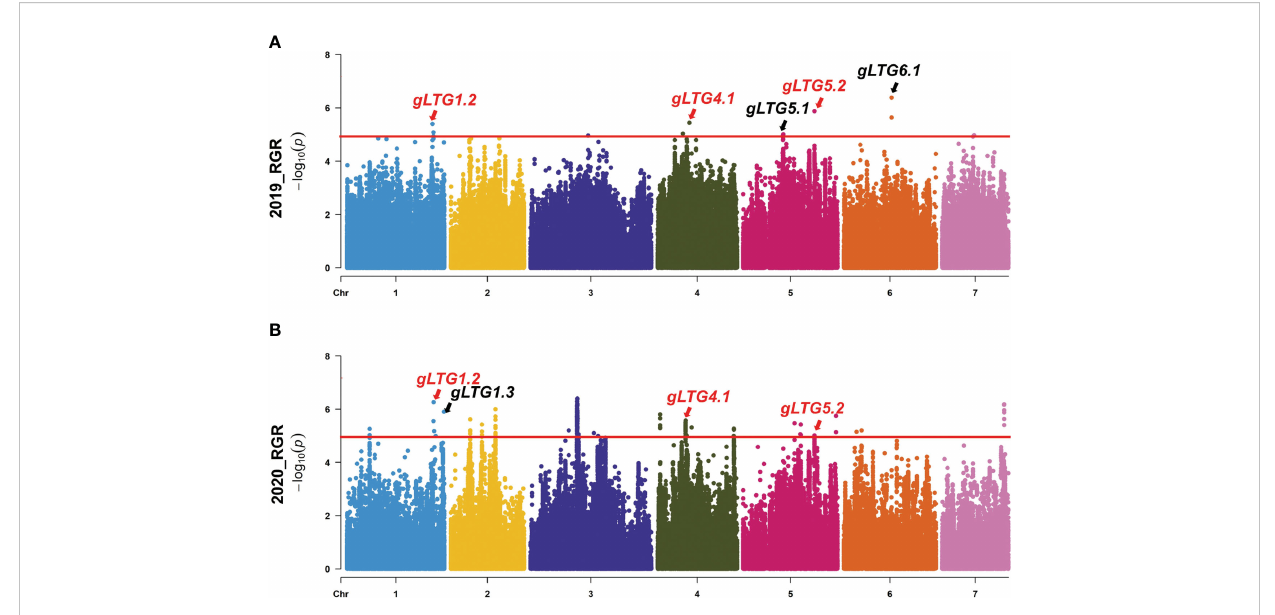
FIGURE 4 Genome-wide association analysis (GWAS) Manhattan plots of (A) RGR in 2019 (B) , and RGR in 2020. The red horizontal lines indicate the signi fi cance threshold ( P < 10 − 6 ). Arrow heads indicate the position of strong